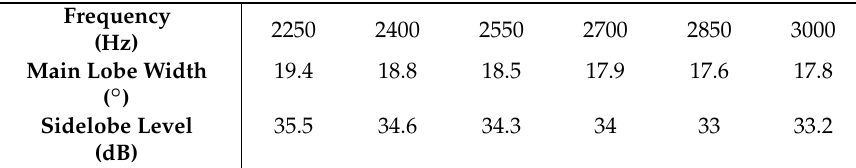
Table 4. Beam parameters of six frequency points for wideband